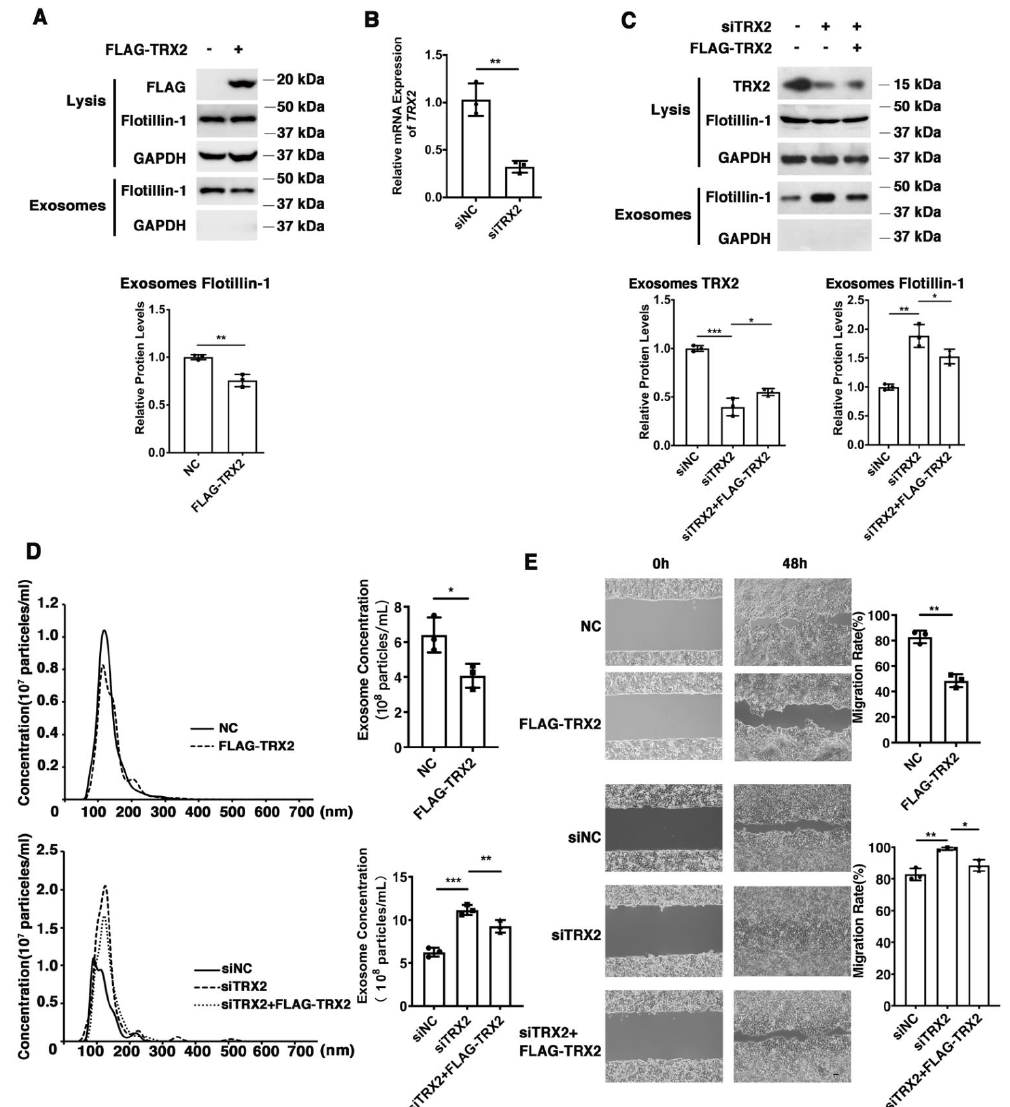
Figure 1. TRX2 plays a role in exosome secretion and cell migration in HCT116 cells. ( A ) HCT116 cells were transfected with pcDNA3.1+ or FLAG − TRX2. After 72 h, exosome pellets were resus- pended in the corresponding volume of PBS according to cell numbers to ensure that the same vol- ume of PBS contained exosomes from the same cell number. The lysis (20 μg) and exosomes (20 μL)